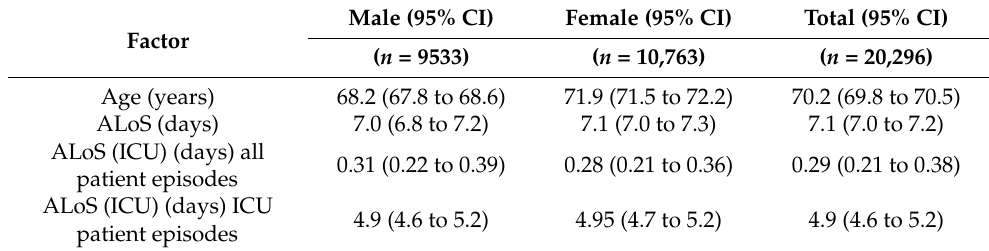
Table 1. CHF patient episode parameters.